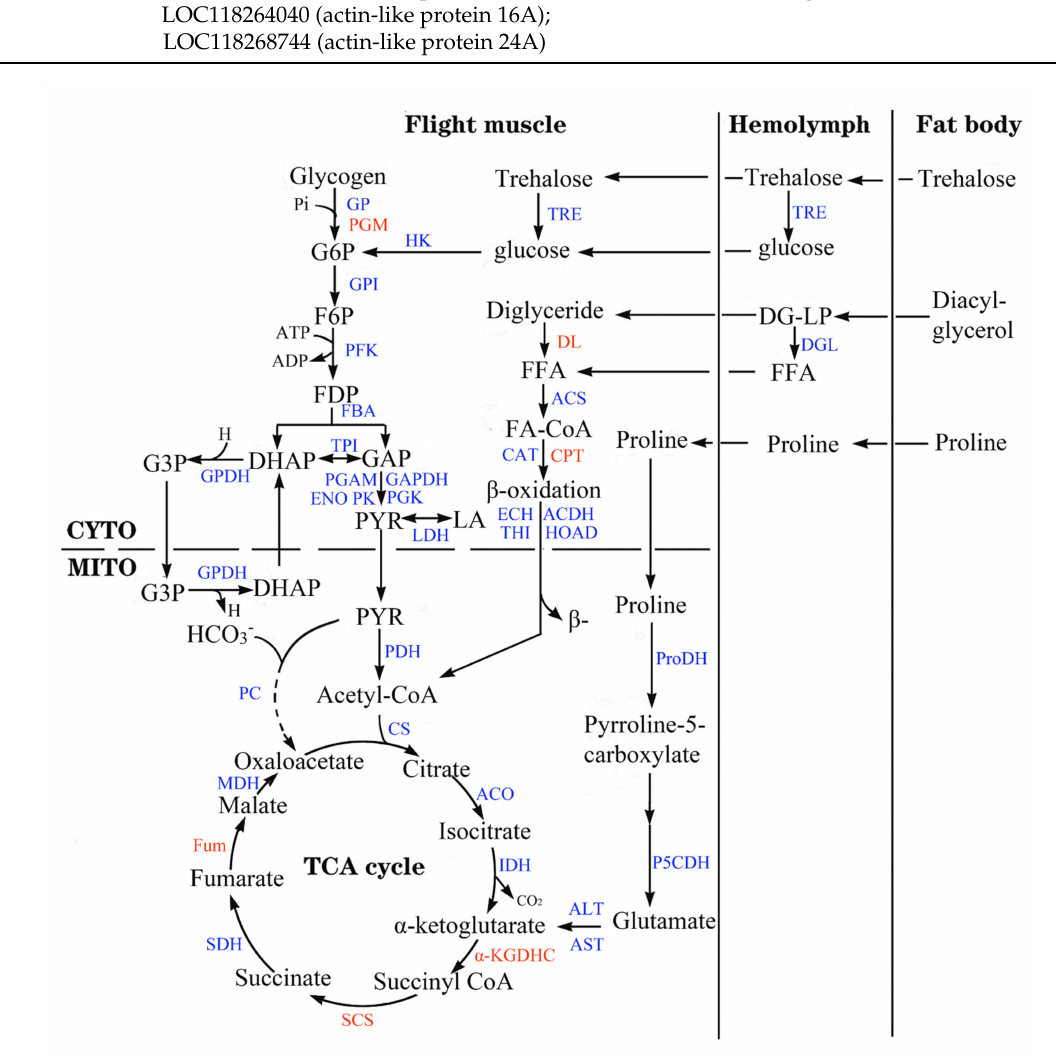
Figure 1. Possible flight energy metabolism pathways and key enzymes in S. frugiperda . The pathways with metabolic substrates and metabolites were constructed based on Thompson and Suarez [8].